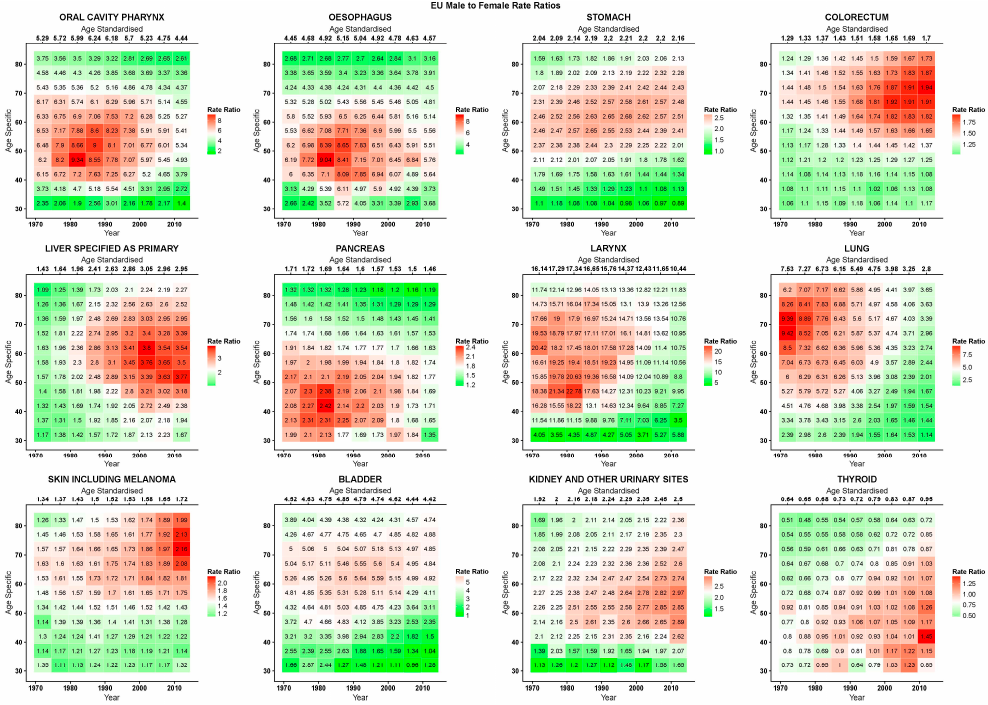
Figure 2. Heatmap tables of age-specific and age-standardised quinquennial male-to-female mortality rate ratios in epithelial cancers in the EU. Int. J. Environ. Res. Public Health 2020 , 17 , x FOR PEER REVIEW rate ratios in epithelial cancers in the EU.